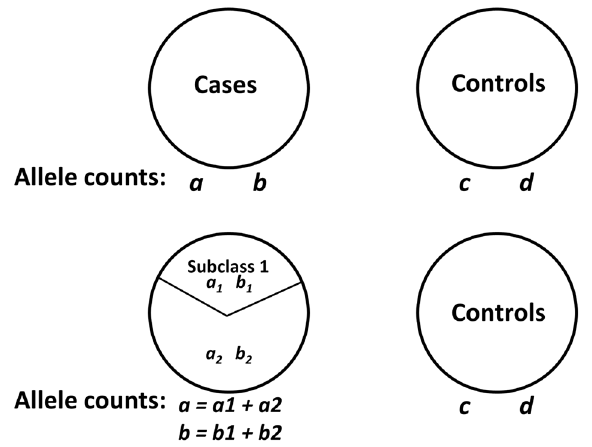
Figure 2. Allele frequency alterations due to the presence of a subgroup. The difference in allele frequencies for a SNP considered classically (top) and as a complex disorder with subgroups (below). In the example, a hypothetical subgroup denoted Subclass 1 contains allele counts a 1 and b 1 , while the rest of the cases contain allele counts a